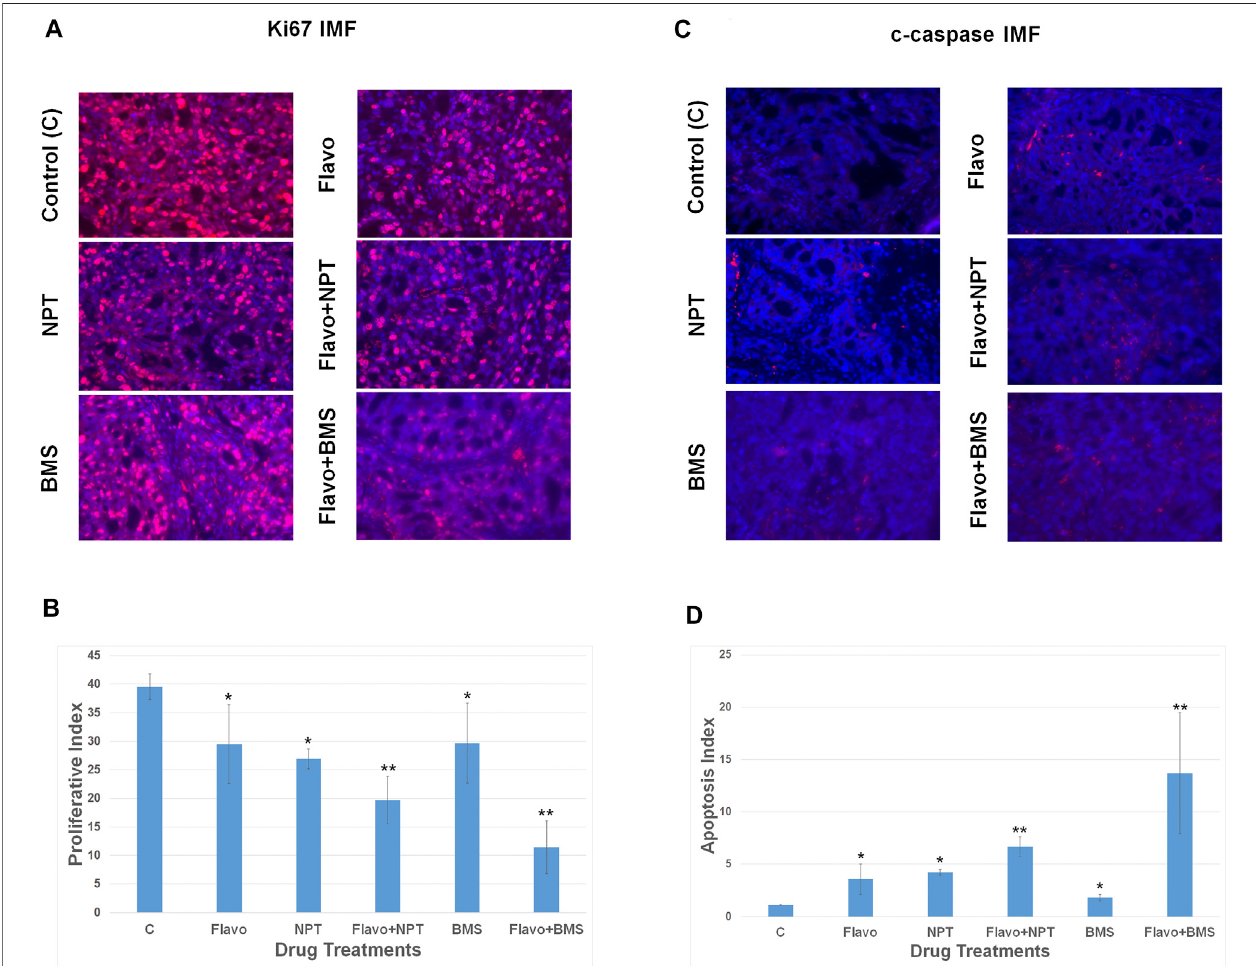
FIGURE 5 | High anti-proliferative and pro-apoptotic in-vivo potency of fl avopiridol alone and in combination with chemotherapy or targeted therapy. Nude mice bearing high c-Myc expressing OE19 cell-derived xenografts were treated with fl avopiridol (Flavo) alone (5 mg/kg in 100 µl of 0.1% DMSO, 5 times a week for 2 weeks) and in combinations with chemotherapeutic agent nanoparticle albumin-bound paclitaxel (NPT) (10 mg/kg in 100 µl of PBS, 2 times a week for 2 weeks) or IGF-1R/IR targeted agent BMS-754807 (BMS) (25 mg/kg in 100 µl of PBS, 5 times a week for 2 weeks). At completion of treatment, tumors were dissected and proceed for immuno fl uorescence(IMF). (A,B) IntratumoralproliferationwasmeasuredbyimmunostainingtissuesectionsforKi67nuclearantigen(Ki67IMF).Ki67-postivecellswere counted in fi ve different high power fi elds and plotted asbar graph. (C,D) Intratumoralapoptosis was measured by staining tumor tissue sections for cleaved caspase 3 (c-caspase IMF). Cleaved caspase 3-positive cells were counted in fi ve different high power fi elds and plotted asbar graph. Dataare expressed as the mean ± standard deviation. * indicates signi fi cantly different from control (C) and ** indicates signi fi cantly different single drug therapy.